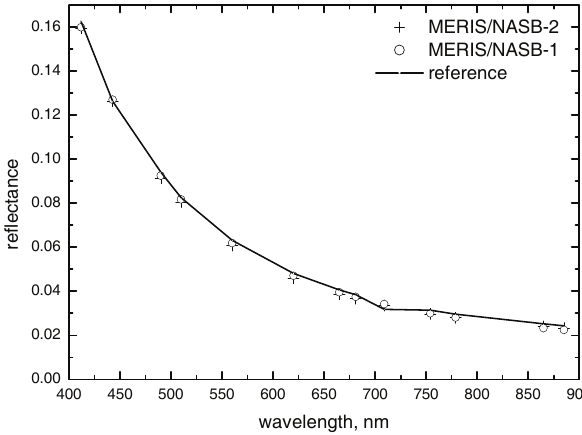
Fig. 13b. The spectral reflectance calculated using derived aerosol models (NASB-1,2) and the “true” one (solid